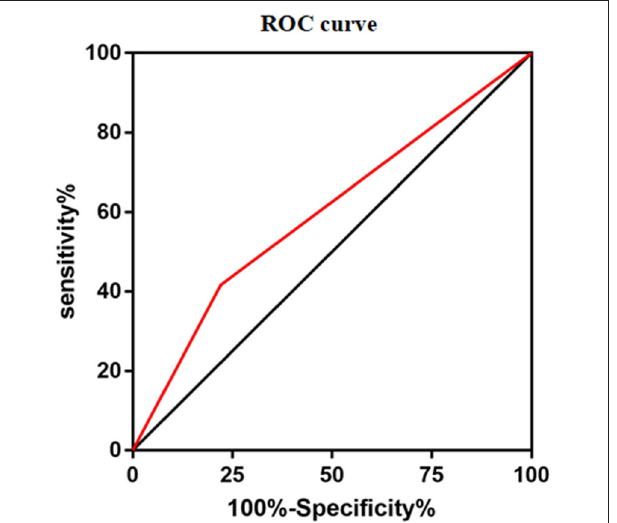
FIGURE 1 | Area under the curve (AUC) of NUDT15 c.415C > T predicting 6-MP related leucopenia was 0.600.